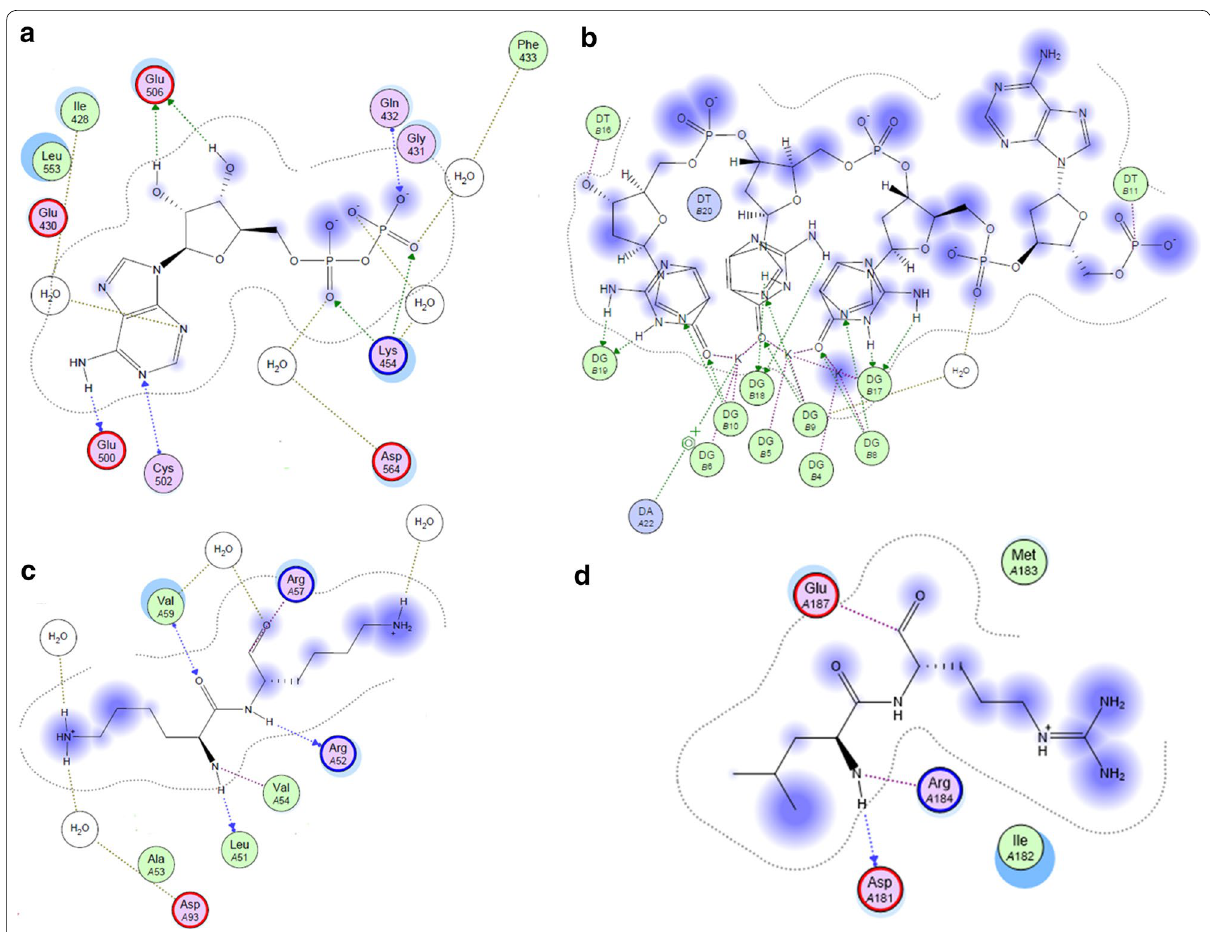
Fig. 8 Molecular docking and interaction of the compound pentanoic acid to the different anticancer cell line targets. a 3-Methyl-4-oxo-pentanoic acid with 1MP8: transferase. Interact with structure of the cancer-related Focal Adhesion Kinase (FAK) and molecule. b 3-Methyl-4-oxo-pentanoic acid with 1ELK. Interaction of 1ELK (MCF-7) VSH domain of TOM 1 (target of myb 1) protein from Homo sapiens with molecule. c 3-Methyl-4-oxo-pentanoic acid with 6AU4: DNA. Interaction with crystal structure of the major quadruplex formed in the human c-MYC promoter and molecule. d 3-Methyl-4-oxo-pentanoic acid with 3SSU. Interaction between crystal structure of vimentin central helical domain and its implications for intermediate filament assembly 3SSU (MDA MB 231) and obtained molecule